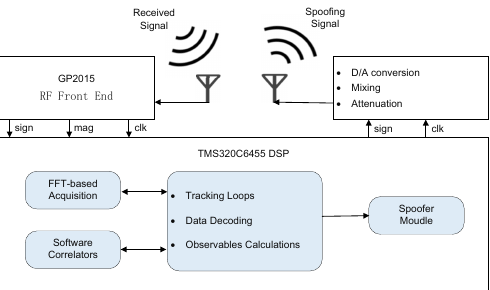
Figure 7. The architecture of a receiver-spoofer [41].